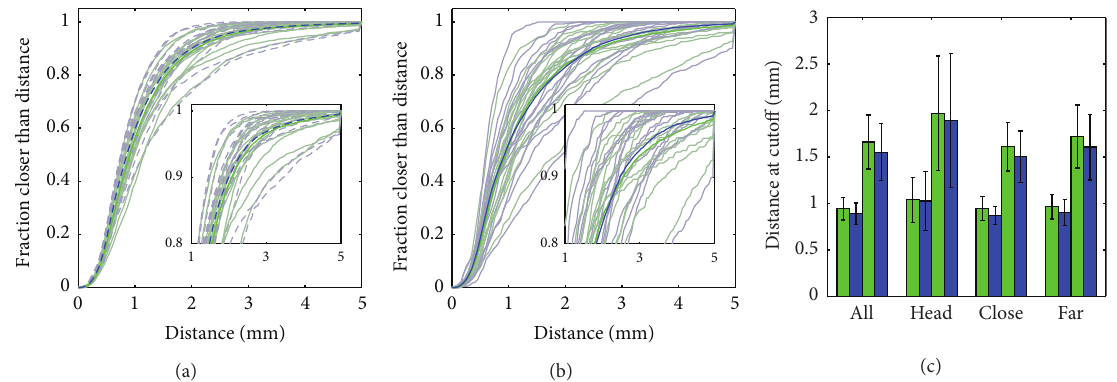
Figure 9: Surface-to-surface distance c.d.f.s including (a) all vertices and (b) only vertices within 10mm of head landmark. Inset shows same data zoomed to ≥ 80%. Plot (c) shows the 50% (left pair in a set of four) and 80% (right pair in a set) crossing for the vertices shown in (a) (“All”) and (b) (“Head”), as well as within 2.5 mm of any landmark (“Close”) or not (“Far”). Green/solid/left of pair: traditional LDDMM; blue/broken/right of pair: GDAS.